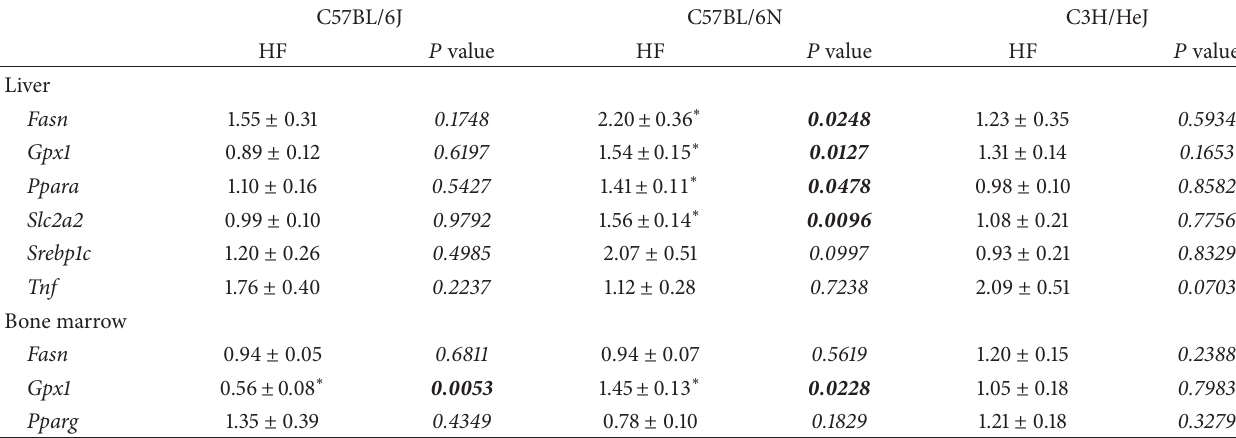
Table 4: Relative fold change of gene expression in the liver and bone marrow in mice fed a high fat diet compared to the control